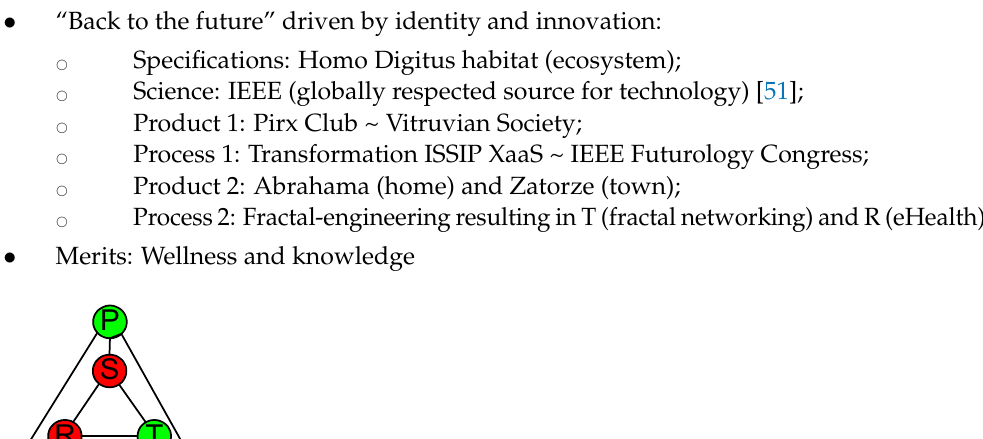
PP Figure 10. Evil ideology with failed R and S but working T. On top of the COVID-19 itself, there are negative phenomena which can be dubbed as triple failure societal diseases (3F) based on ill-functioning of R, S, and T. In an example